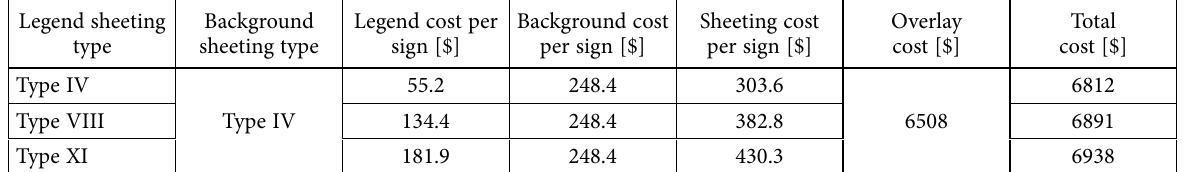
Table 5. Total cost of replacing sign sheeting with various legend sheeting types